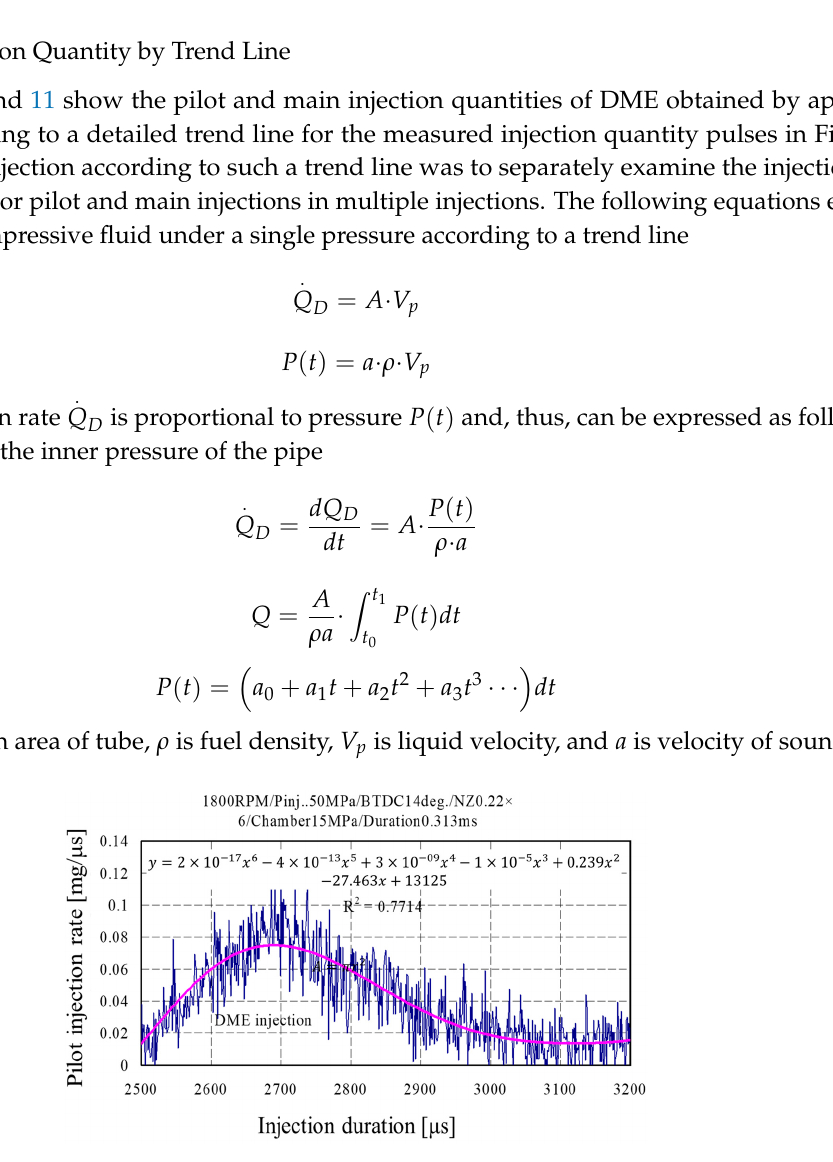
Figure 10. Injection rate characteristic for only the pilot injection quantity of the pilot and main injection durations for DME.